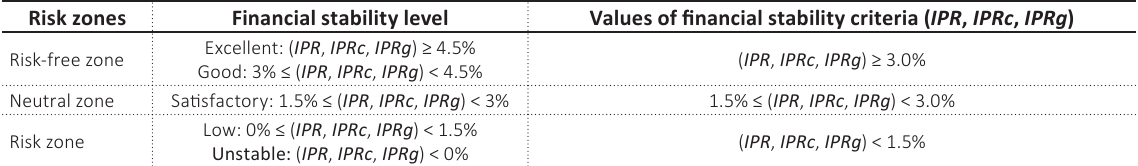
Table 2. Risk zones Risk zones Financial stability level Values of financial stability criteria ( IPR , IPRc , IPRg )